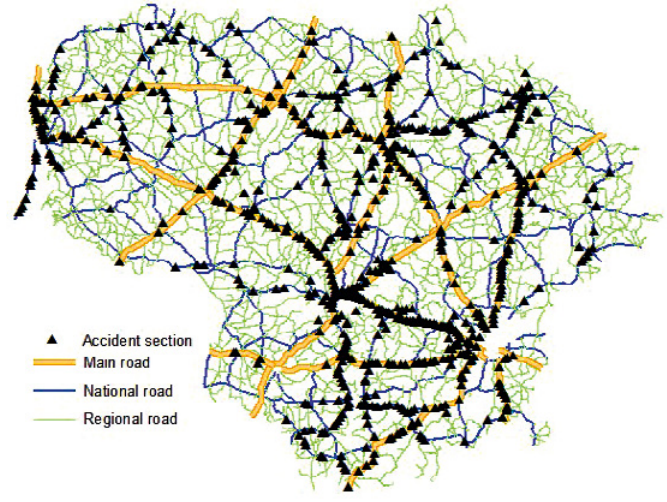
Figure 3. Accident